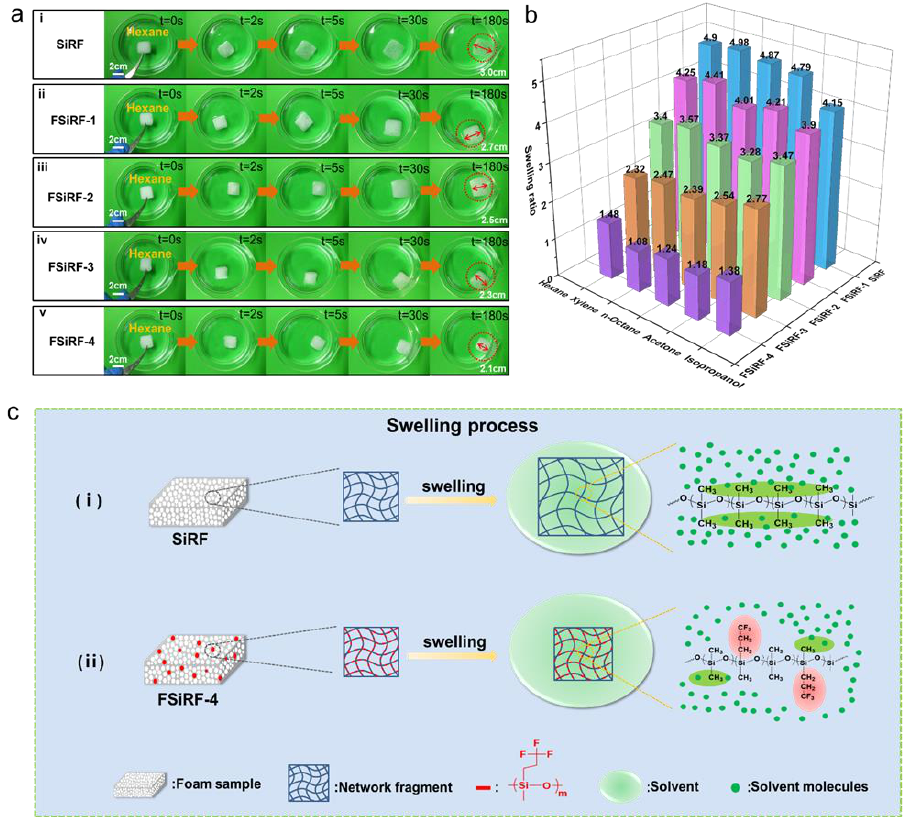
Figure 5. ( a ) Swelling process of the FSiRF materials in Hexane and ( b ) swelling ratios of FSiRF materials for different organic solvents, which shows that the swelling resistance of FSiRF material is enhanced with the increase in fluorine content. ( c ) Diagram and comparison of the antiswelling mechanism of FSiRF materials with different fluorine contents of 0 and 50%.